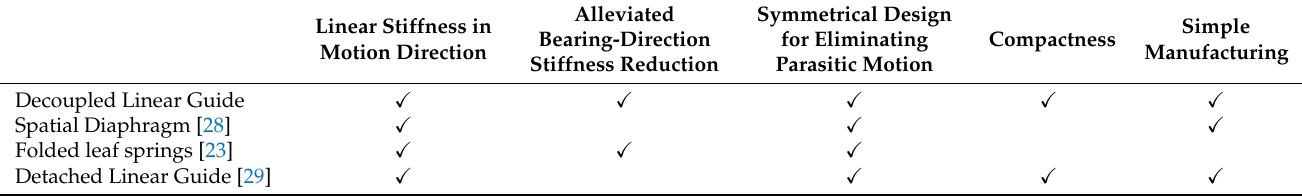
Table 1. The summarized comparison between types of compliant spatial linear